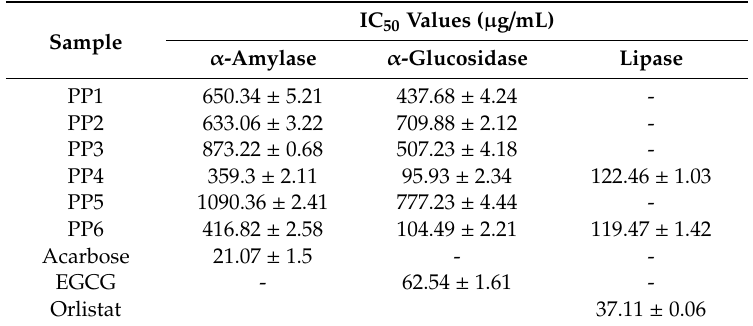
Table 1. The Inhibitory effects of the different fractions from the methanolic extract of L. tetragona against α -amylase, α -glucosidase, and lipase activities (mean ± SD).